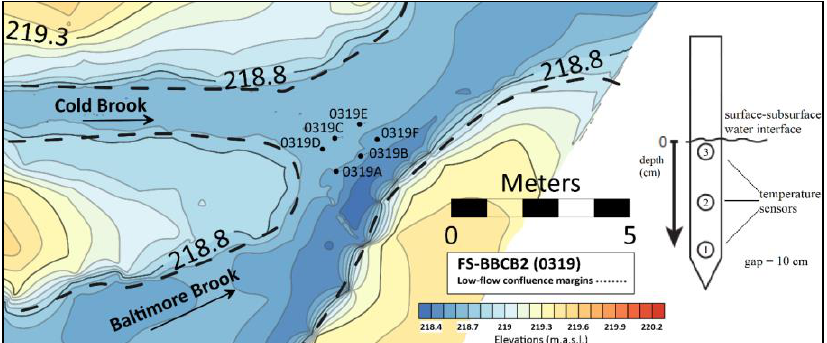
Figure 4. Locations of temperature rods used for vertical hydraulic gradient tests, for FS-BBCB2 and the temperature rod setup (right).